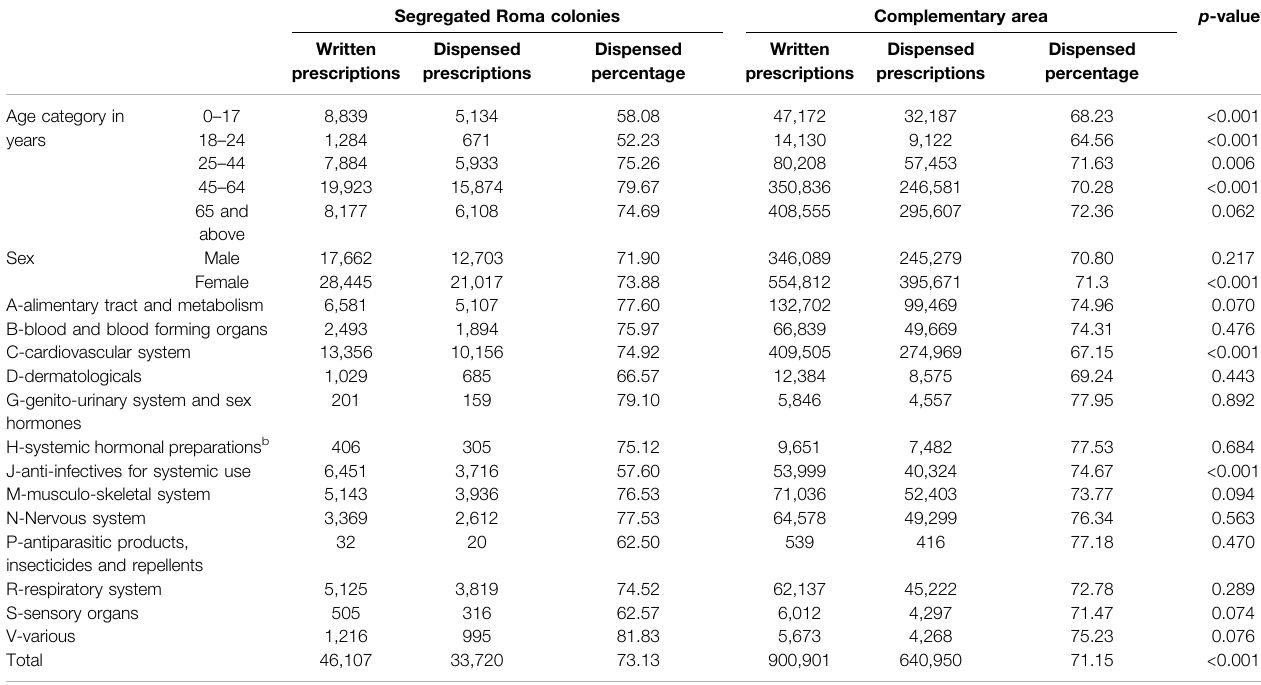
TABLE 1 | Crude prescription redemption ratio by sociodemographic characteristic and ATC class for segregated Roma colonies and complementary area.